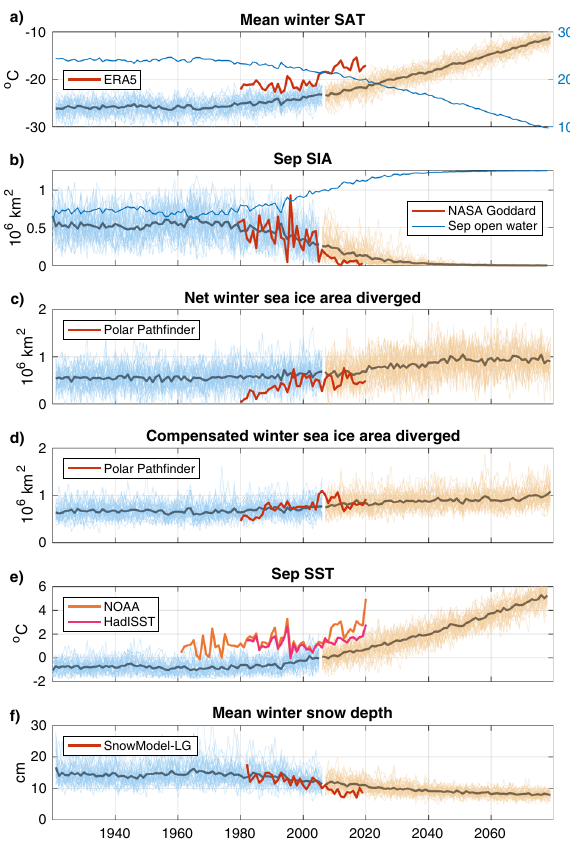
Fig. 6 | Key climate variables. Timeseries of climate variables from CESM-LE used in the linear model, with observation-based estimates superimposed in red (from ERA5,NASAGoddard,PolarPath fi nder,NOAAOISSTv2,HADISSTandSnowModel- LG). All 40 ensemble members shown in light blue (20C) and orange (RCP8.5). Ensemble mean indicated by darker lines. a Surface air temperatures, CESM-LE ensemble-mean Δ T inblue;( b )Sepseaicearea(SIA),CESM-LEensemble-meanSep open water area ( A Sep ) in blue; ( c ) net area diverged; ( d ) compensated area diverged;( e ) September seasurface temperature(Sep SST); ( f ) Snowdepth onice.